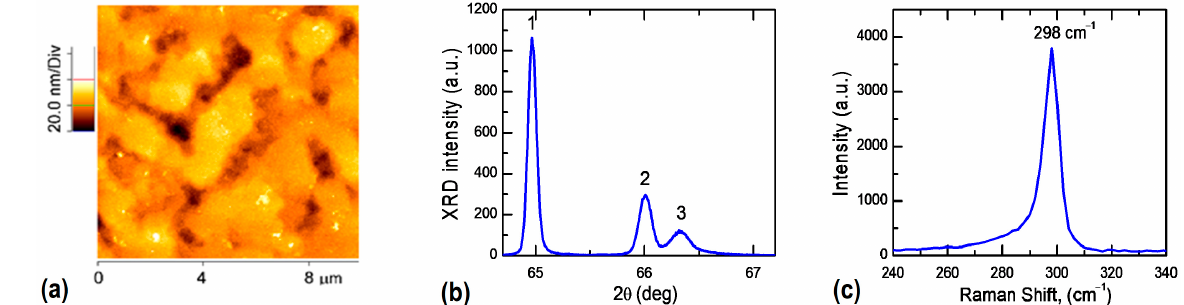
Figure 1. ( a ) AFM image, XRD ω /2 θ scan ( b , c ) micro-Raman spectra, exited by 514 nm, of Ge 0.95 Sn 0.05 epitaxial layer. Explanation of XRD (004) peaks: (1) Ge 0.95 Sn 0.05 fully strained on Ge; (2) Ge relaxed; (3) Si 0.06 Ge 0.94 fully strained below Ge.